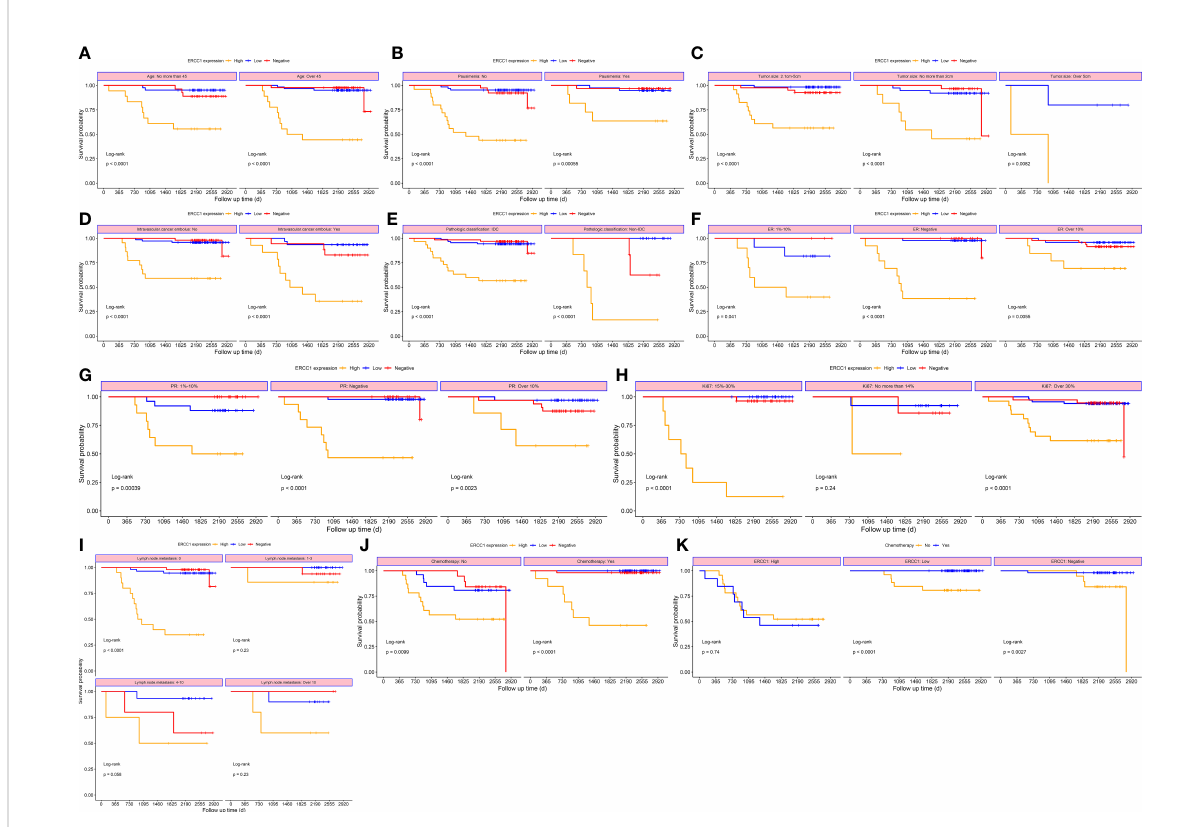
FIGURE 7 Survival curves strati fi ed based on clinical factors (DFS) (A) Age (B) menopause (C) Tumor size (D) Intravascular cancer embolus (E) Pathologic classi fi cation (F) ER (G) PR (H) Ki-67 (I) Lymph node metastasis (J) Chemotherapy (K) ERCC1 expression.